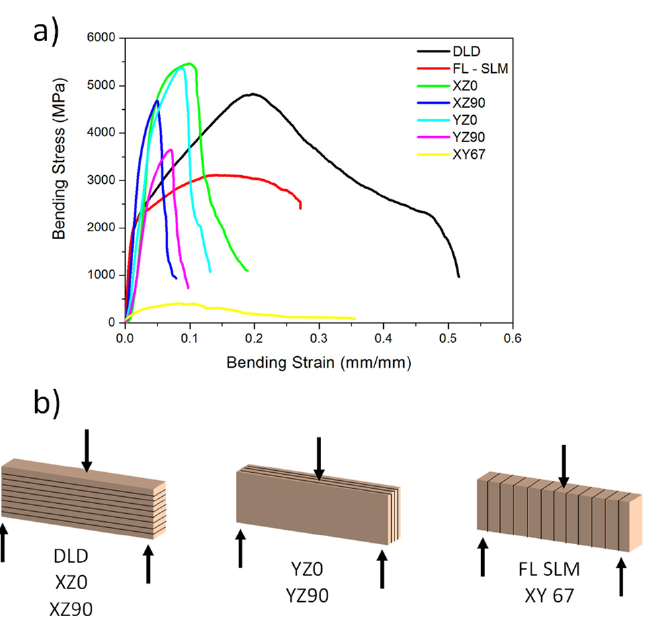
Figure 12. ( a ) Flexural tests of the different samples manufactured and ( b ) scheme of the flexural tests of the parts with their layers tests of the parts with their layers marked.